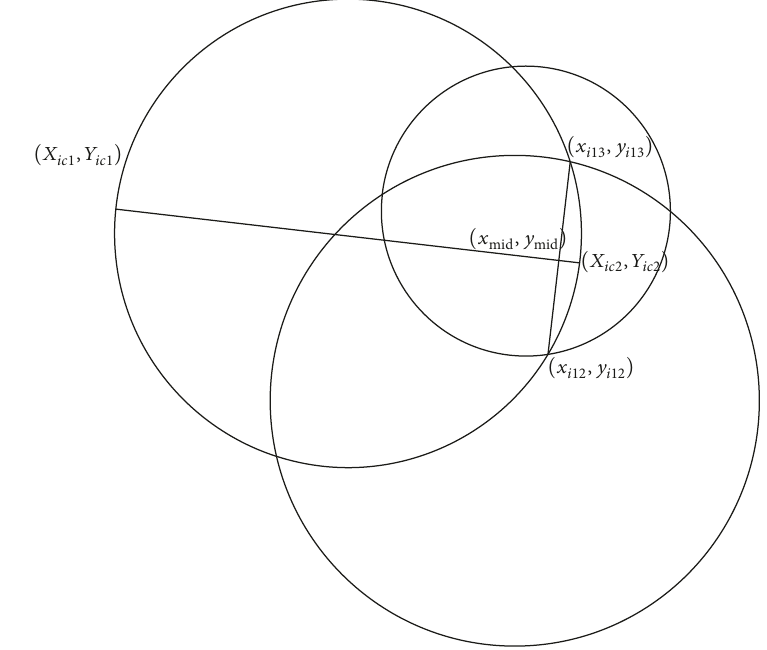
Figure 9: Three intersecting circles of unequal radii.